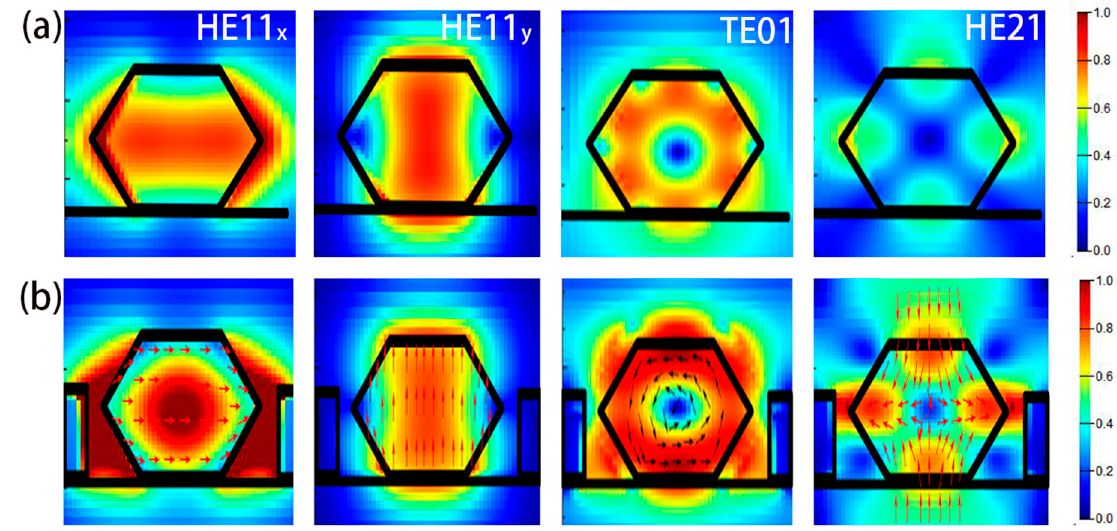
Figure 4. Normalized cross-sectional electric field distribution of HE11 x , HE11 y , TE01 and HE21 modes for ( a ) the pure NW on the silica platform, and ( b ) the PhC NW on the SOI substrate, respectively.